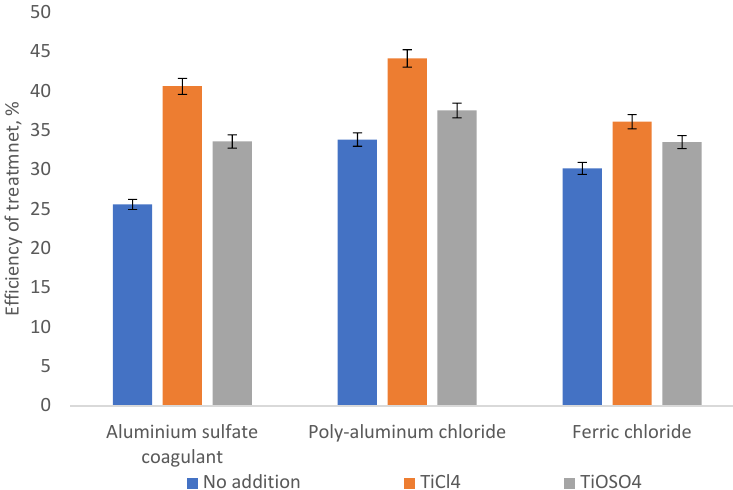
Figure 4. Efficiency of removing organic compounds (COD) from the alcohol industry wastewater by various coagulants.